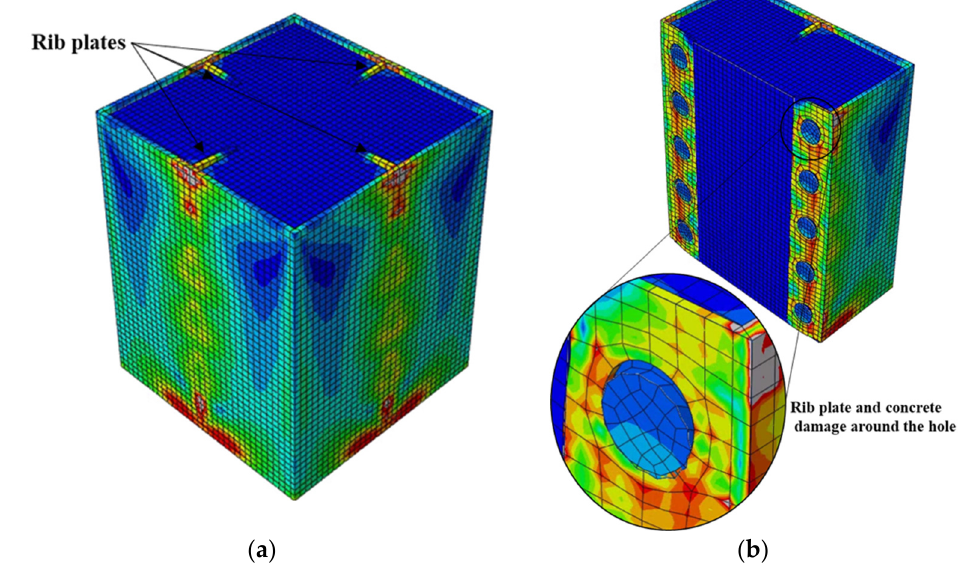
Figure 13. Typical failure mode of CFST columns having rib plates with circular hole connectors: ( a ) stress distribution and ( b ) failure mode.